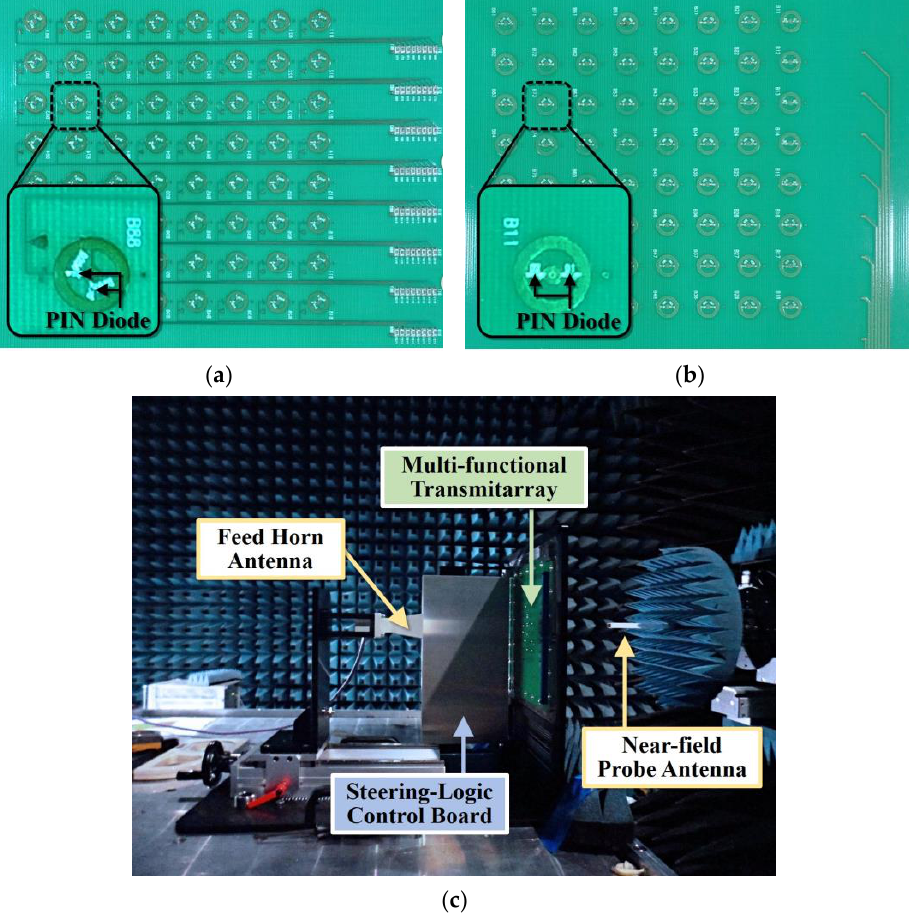
Figure 6. Fabricated 8 × 8 transmitarray: ( a ) top view (Tx patch); ( b ) bottom view (Rx patch); ( c ) far-field pattern measurement based on near-field antenna measurement system.